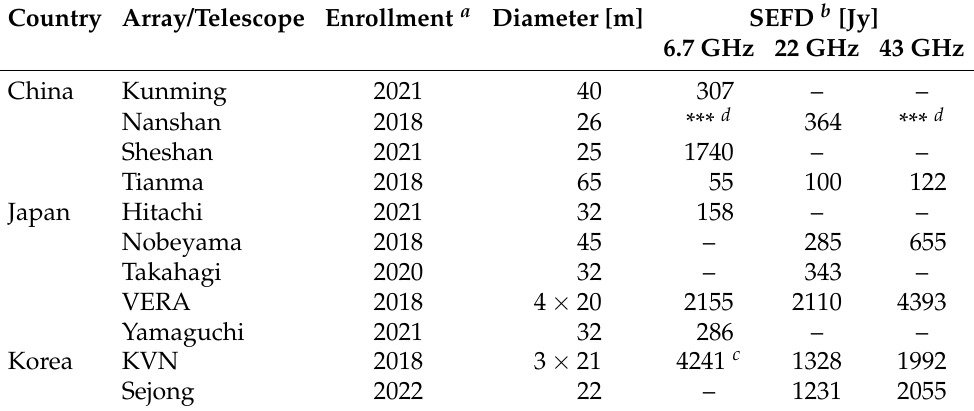
Table 1. Participating arrays and telescopes in EAVN.